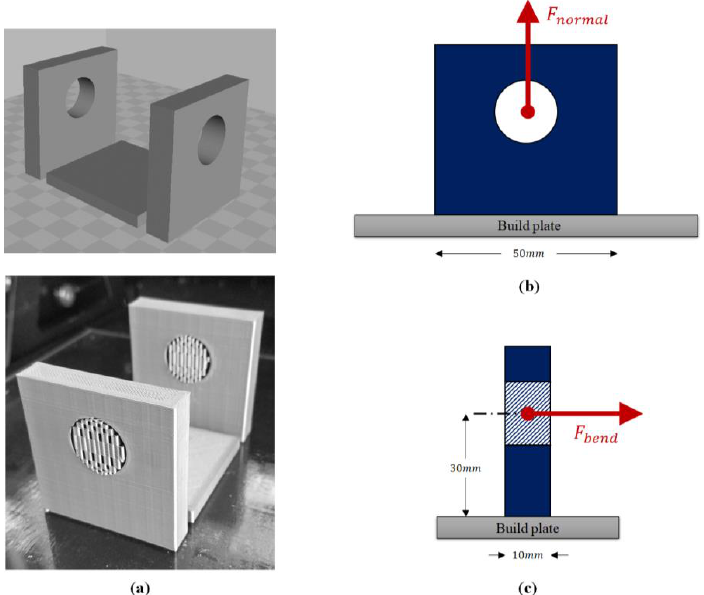
Figure 18. Print bed adhesion strength test setup. ( a ) Sample printing configuration; ( b ) normal strength test configuration; and ( c ) bending test configuration.